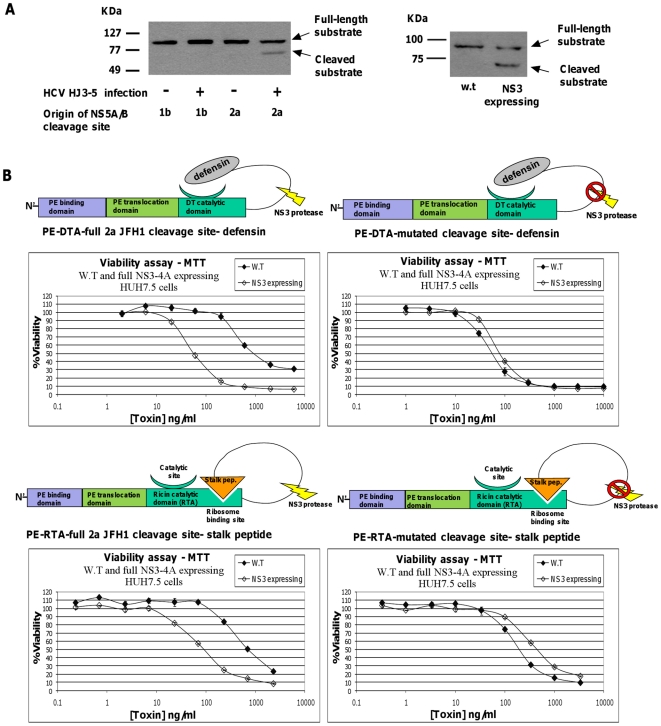
Substrate cleavage efficiency analysis and viability assay of NS3 expressing Huh7.5 cells treated with zymoxins.(A). In vivo substrate cleavage efficiency analysis. Left panel: Huh7.5 cells uninfected or infected with 1a/2a chimeric virus HJ3-5 were seeded (3×105 cells per well) in 6 well plate. After 24 hours, cells were transfected with 2µg of the vector “pCMV/MBP-EGFP-full 1b NS5AB-CBD” or “pCMV/MBP-EGFP-full 2a JFH1 NS5AB-CBD” incorporating NS3 P10-P8′ and P10-P10′ cleavage sites from 1b genotype or 2a genotype (strain JFH1) NS5A/B junctions, respectively. 48 hours post transfection, cells were lysed and samples of 20–60 µg protein from total cell extracts (normalized to contain similar quantities of total cleavage substrate by evaluation of transfection efficiency using fluorescence microscopy analysis) where analyzed by immunoblotting with mouse-serum anti-MBP. Right panel: w.t Huh7.5 cells or Huh7.5 cells stably and constitutively expressing EGFP-full NS3-4A were seeded (3×105 cells per well) in 6 well plate. After 24 hours, cells were transfected with 2µg of the vector “pCMV/MBP-EGFP-full 2a JFH1 NS5AB-CBD”. 48 hours post transfection, cells were lysed and samples of 15 µg protein from total cell extracts where analyzed by immunoblotting with mouse-serum anti-MBP followed by HRP-conjugated secondary antibodies and ECL development. (B). Viability assay: w.t or EGFP-full NS3-4A expressing Huh7.5 cells were seeded (1×104 cells per well) in 96-well plates. After 24 hours, cells were incubated for 96 hours with serial dilutions of the cleavable toxins “PE-DTA-full 2a JFH1 cleavage site-defensin” and “PE-RTA-full 2a JFH1 cleavage site- stalk peptide”, or their uncleavable controls. The relative fraction of viable cells was determined using an enzymatic MTT assay. Each point represents the mean ±SD of a set of data determined in triplicates.